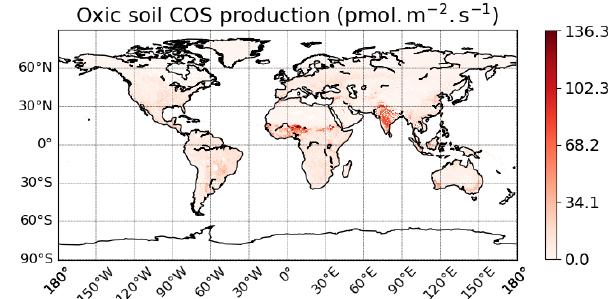
Figure D2. Mean spatial distribution of oxic soil COS production term over 2010–2019. The map resolution is 0.5 ◦ × 0.5 ◦ .